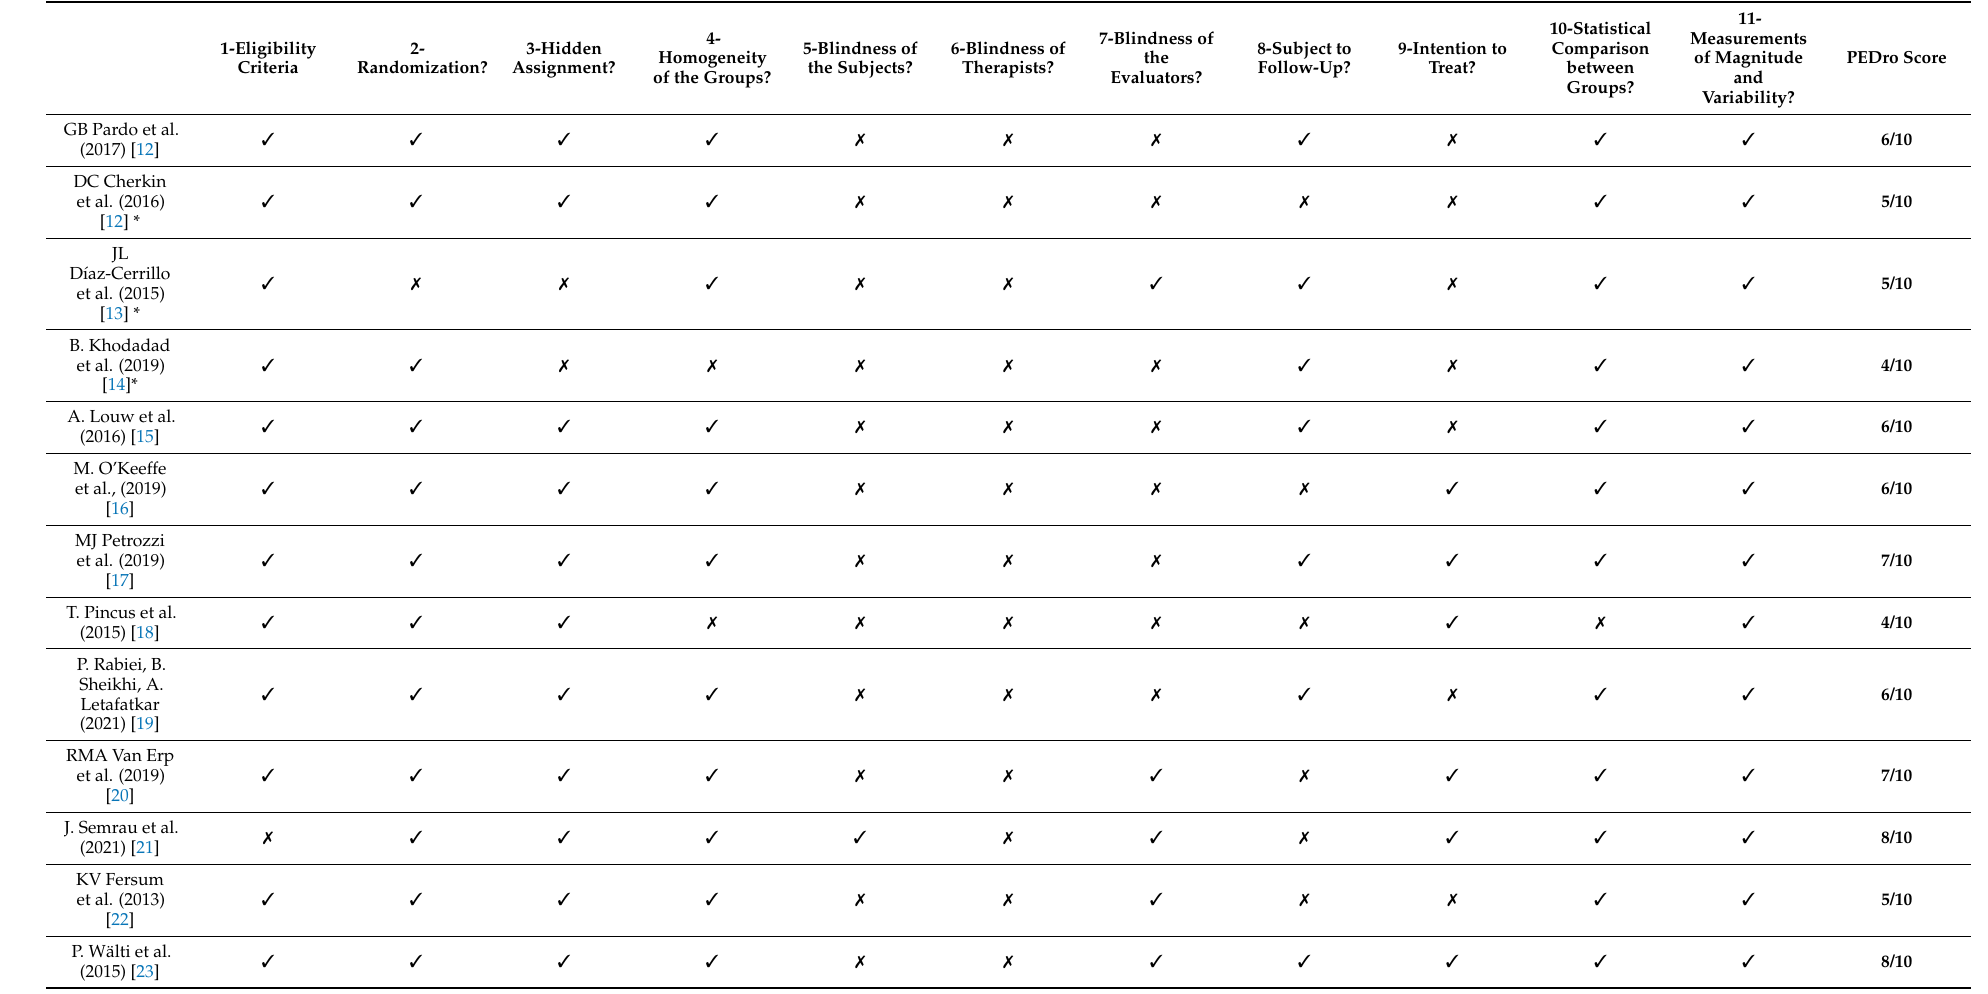
Table 3. PEDro scale for each